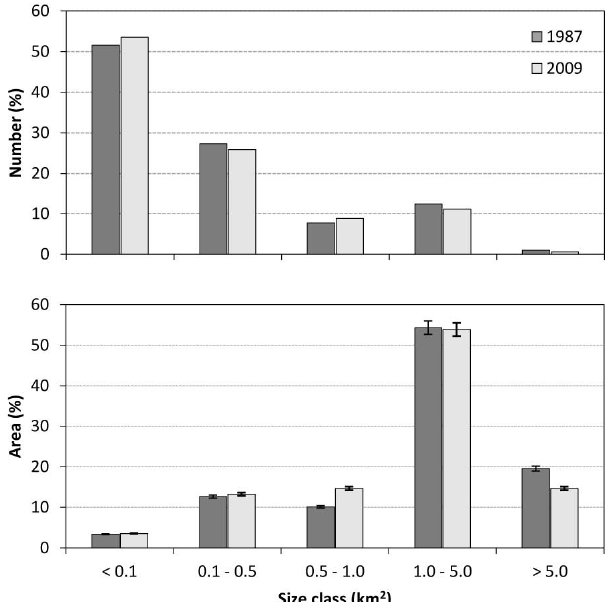
Fig. 6. Bar graphs showing percentages of glacier number and area per size classes. The area in 1987 is used as the reference for size class